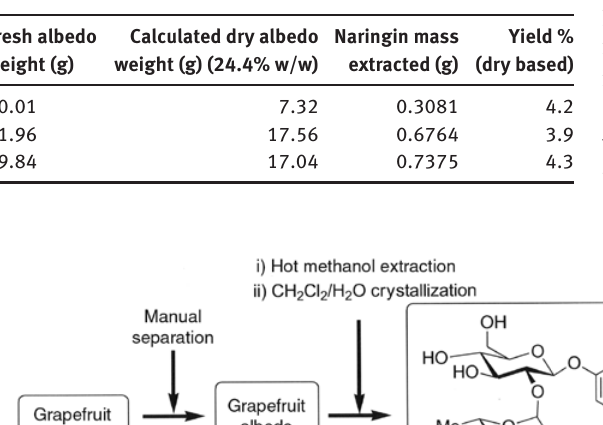
Table 3: Extraction data from fresh albedo in Method C.